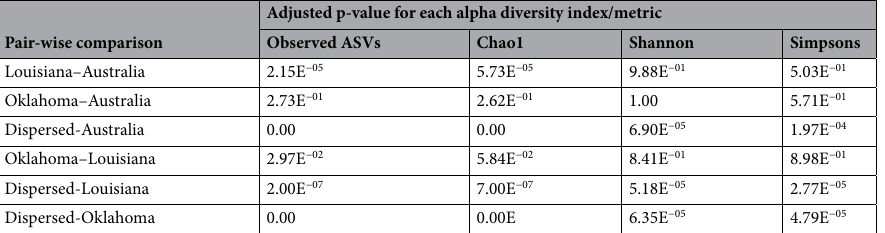
Table 2. Adjusted p-values for the pairwise comparisons of species richness and evenness metrices for healthy mare endometrial lavage samples, based on their geographical origin. Observed ASVs and Chao1 column contain post-hoc adjusted p-values derived using Tukeys HSD. Shannon and Simpsons columns contain the same derived using Dunn Test with B–H correction 21 . Cells containing significant adjusted p-values are